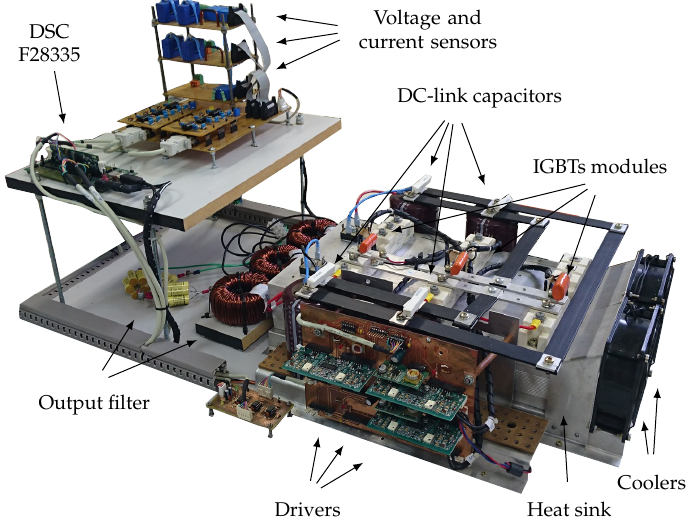
Figure 11. Three-phase prototype built in